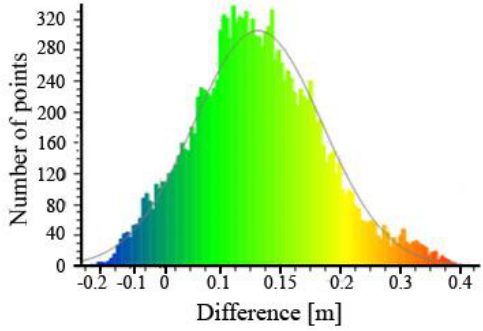
Figure 17. A graph showing a distribution of the cloud deviations of Test Area No. 1. The average deviation value was 0.13 m, and the standard deviation of 0.09 m.